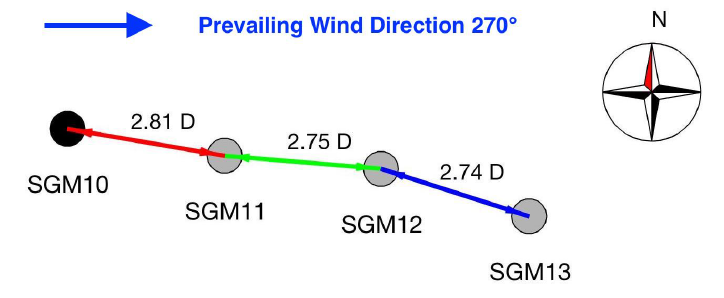
Figure 2. The two-dimensional representation of the layout of the cluster. Inter-turbine distances are